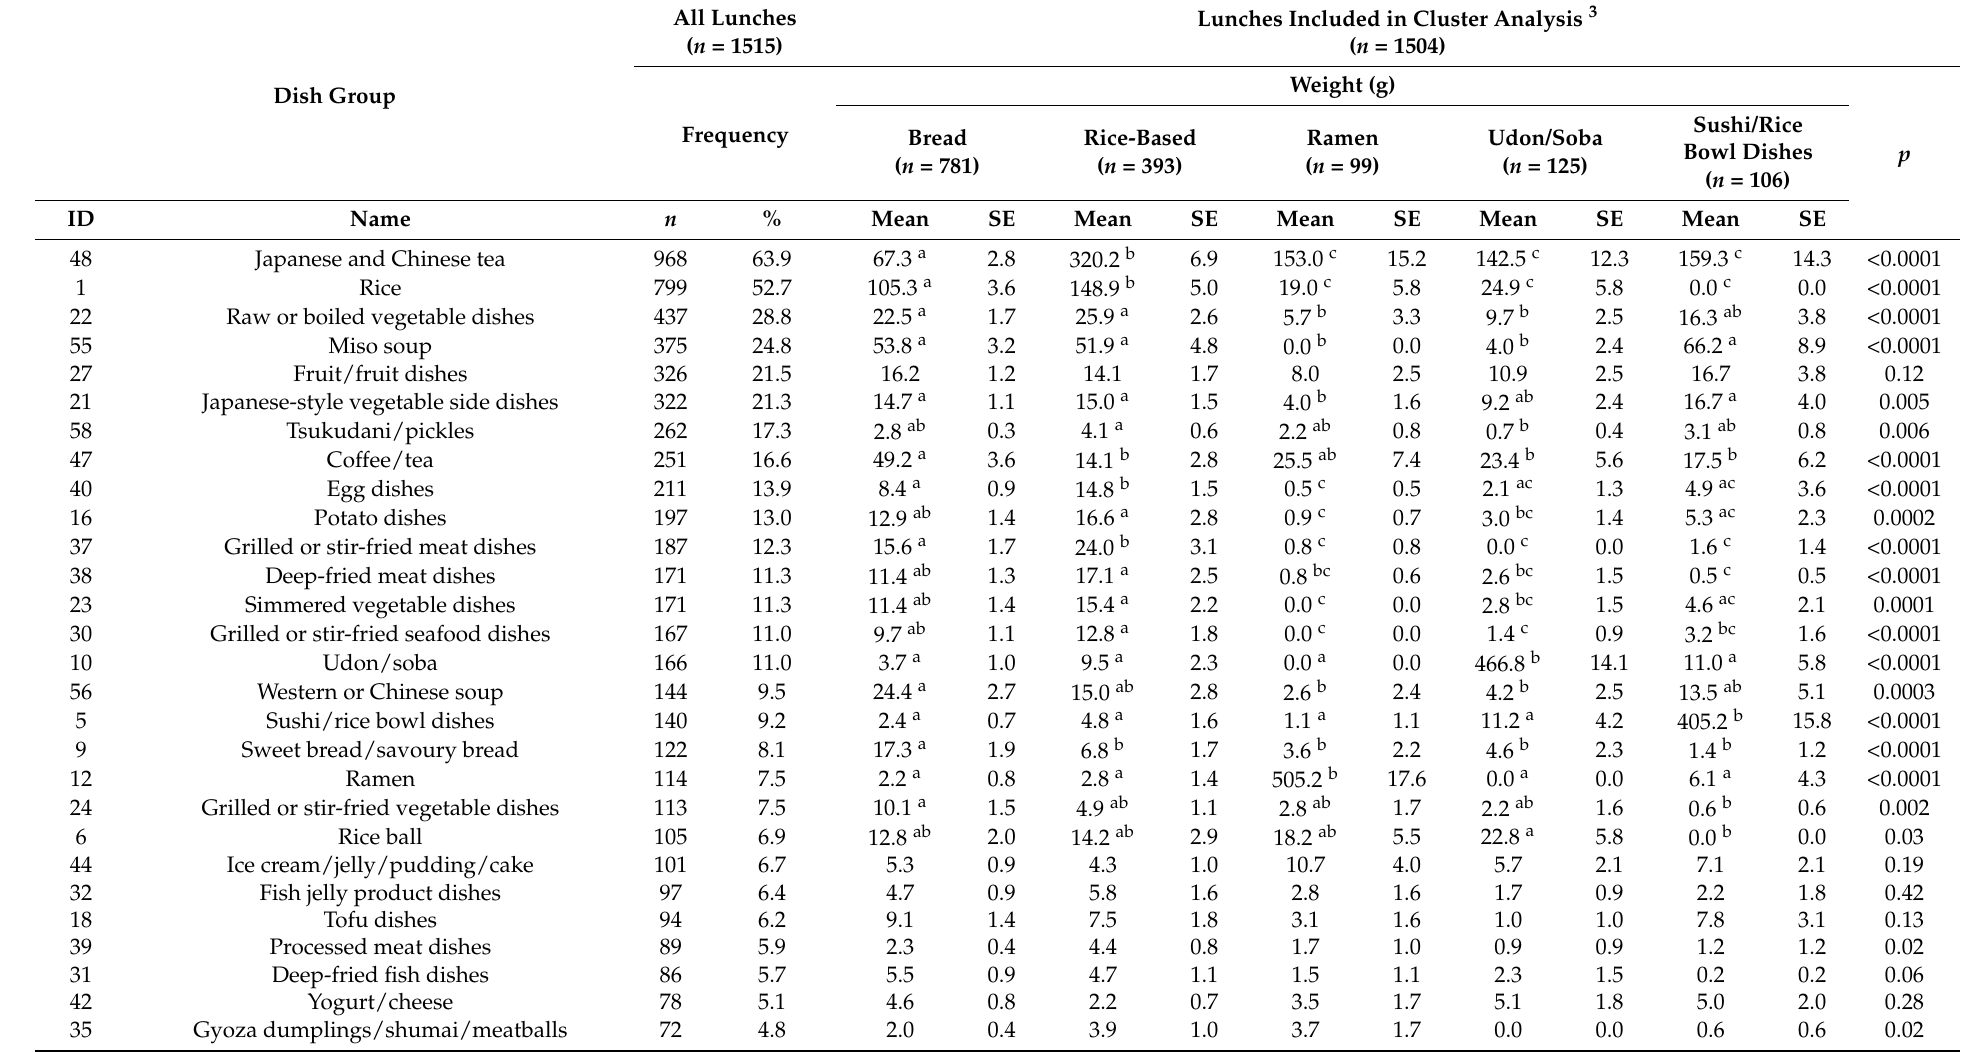
Table 2. Consumption frequency of dish groups in all lunches 1 and weight (g) of dish groups in each dietary pattern 2